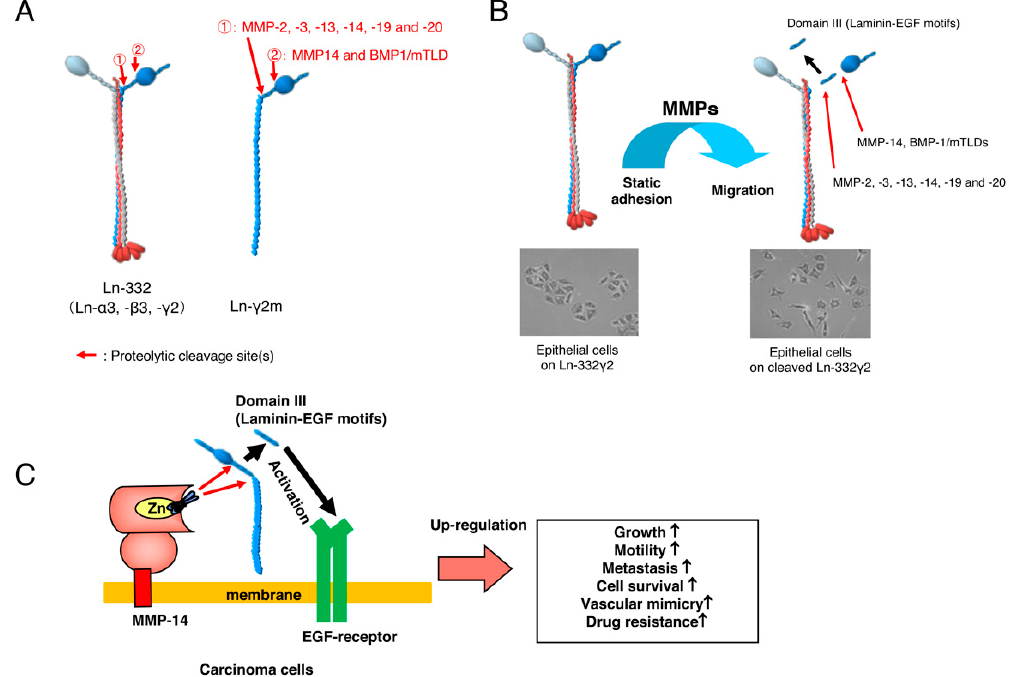
Figure 1. ( A ) The γ 2 chain of Ln-332 trimer and monomeric Ln- γ 2 chains (Ln- α 3 chain: red, Ln- β 3 chain: grey, Ln- γ 2 chain: blue). Proteolytic processing sites of γ 2 chain by MMPs ( ① ) or MMP-14 ( ② ) ( B ) Proteolytic processing of Ln- γ 2 chain occurs at cell surface for subsequent regulatory cellular functions (red arrows). Proteolytic processing of γ 2 chain converts Ln-332 function from static adhesion to migratory substance. ( C ) Membrane type-1 matrix metalloproteinase (MMP14) cleaves Ln- γ 2 chin at both sites and releases the Domain III (laminin-EGF motif) from cancer cells (red arrows), resulting in upregulation of malignant progression of tumor cells through EGFR activation. Figure 1B,C are modified from Koshikawa et al. [8], and Shenk et al. [9].